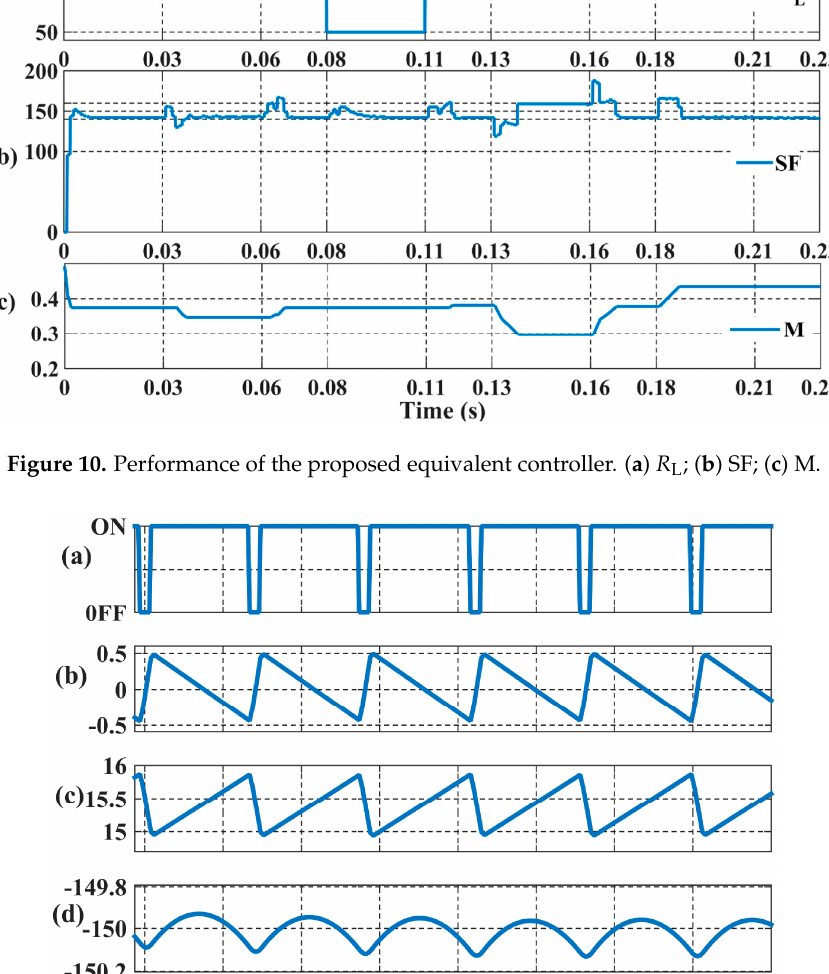
Figure 11. Output voltage and current ripple transients. ( a ) Gate Signal; ( b ) Control Signal (u); ( c )